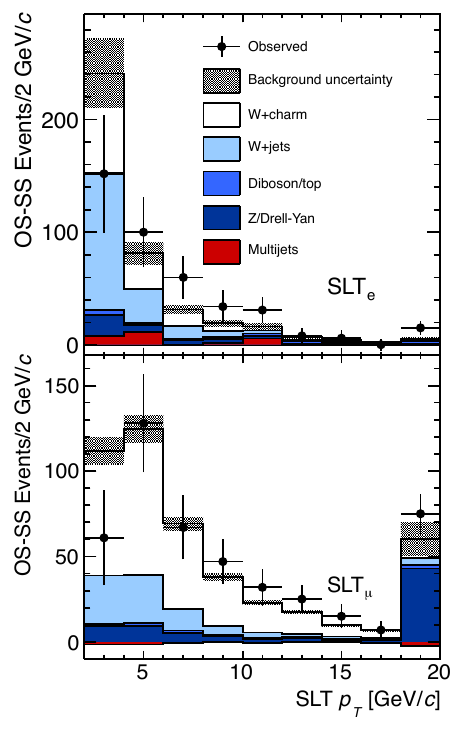
Figure 4. The soft electron and soft muon p T distributions mea- sured using the CDF detector [14]. The W + c contribution is de- rived using ALPGEN simulations normalised to the measured cross